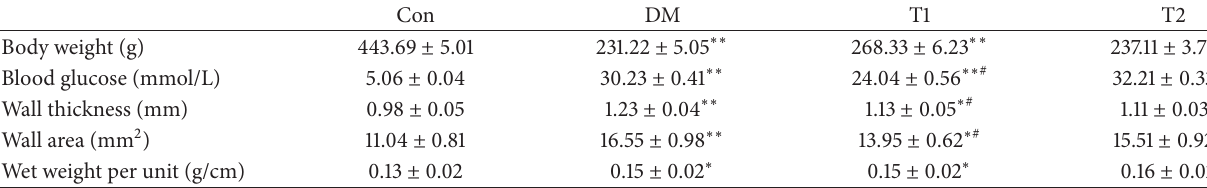
Table 1: Parameters of glucose, body weight, and morphometry of colon.